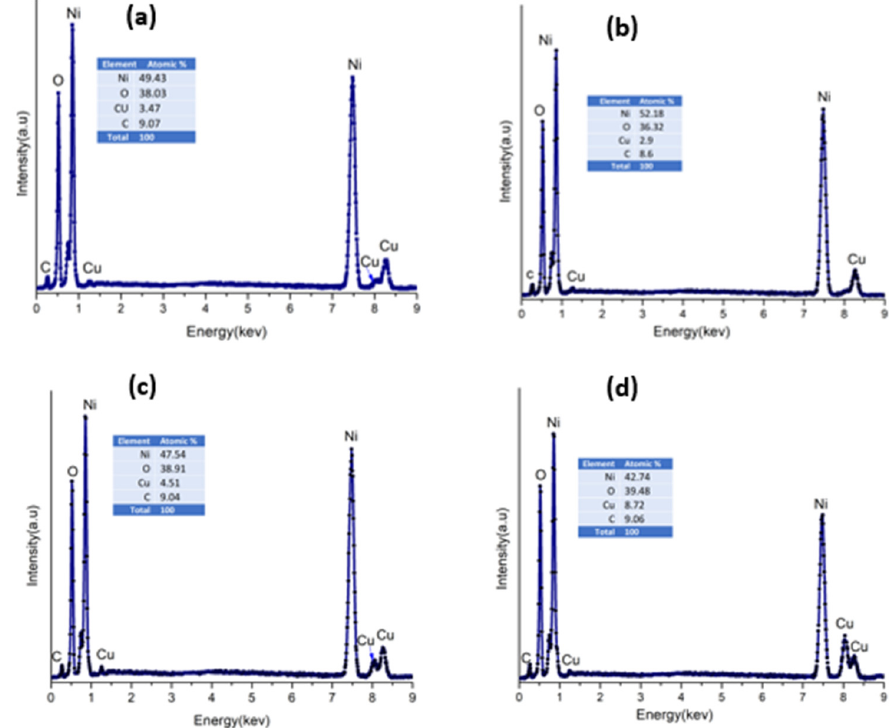
Figure 4. EDS spectrum of green synthesized NiO thin films on Cu substrate prepared at Rotational speeds (RS) of ( a ) 700 RPM, ( b ) 900 RPM, ( c ) 1100 RPM, and ( d ) 1300 RPM.